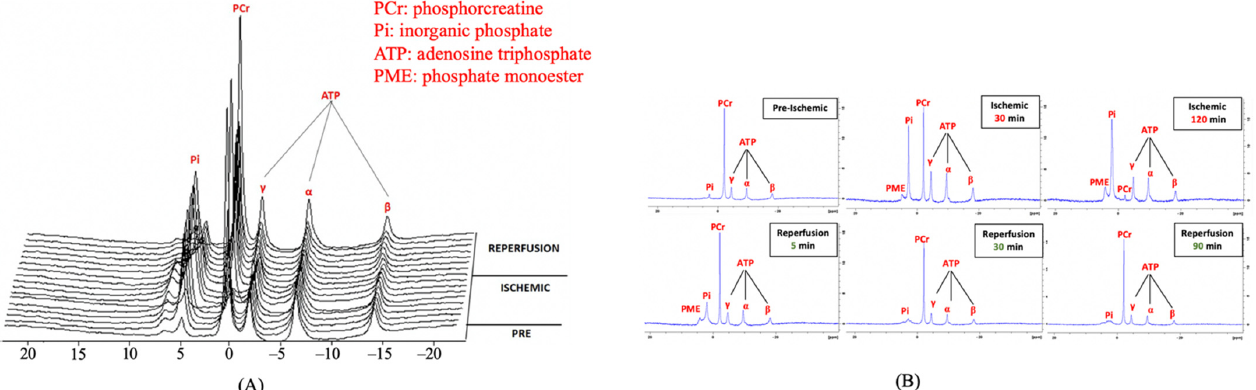
Figure 5. The dynamic graph of the 31 P-MRS spectrum. ( A ) Time series of the dynamic 31 P-MRS spectrum in the pre- ischemic, ischemic, and reperfusion states. ( B ) The change of the 31 P-MRS wave during the experiment. In the ischemic state, a phosphate monoester (PME) peak appeared at 30 min and gradually increased until 120 min of the ischemic state. At the beginning of the reperfusion state, the PME peak started to decrease, and completely disappeared at 185 min of the reperfusion state.